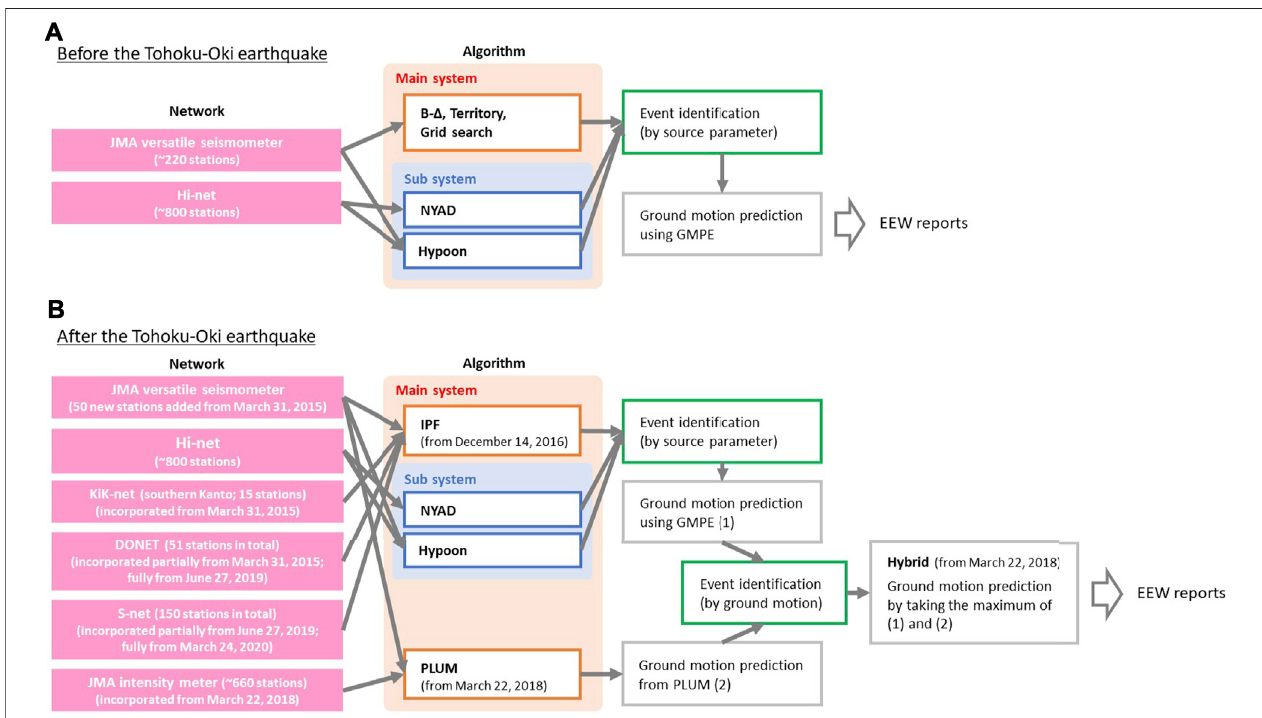
FIGURE 1 | Data fl ow diagrams with seismic networks and ground motion prediction algorithms of the JMA EEW system (A) before and (B) after the Tohoku-Oki earthquake.